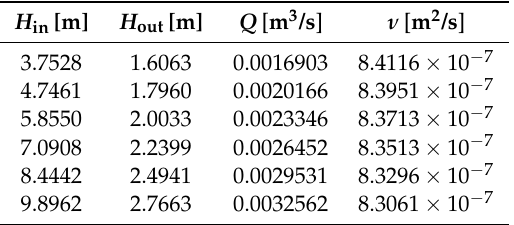
Table 1. Dataset with measurements at six operating points.